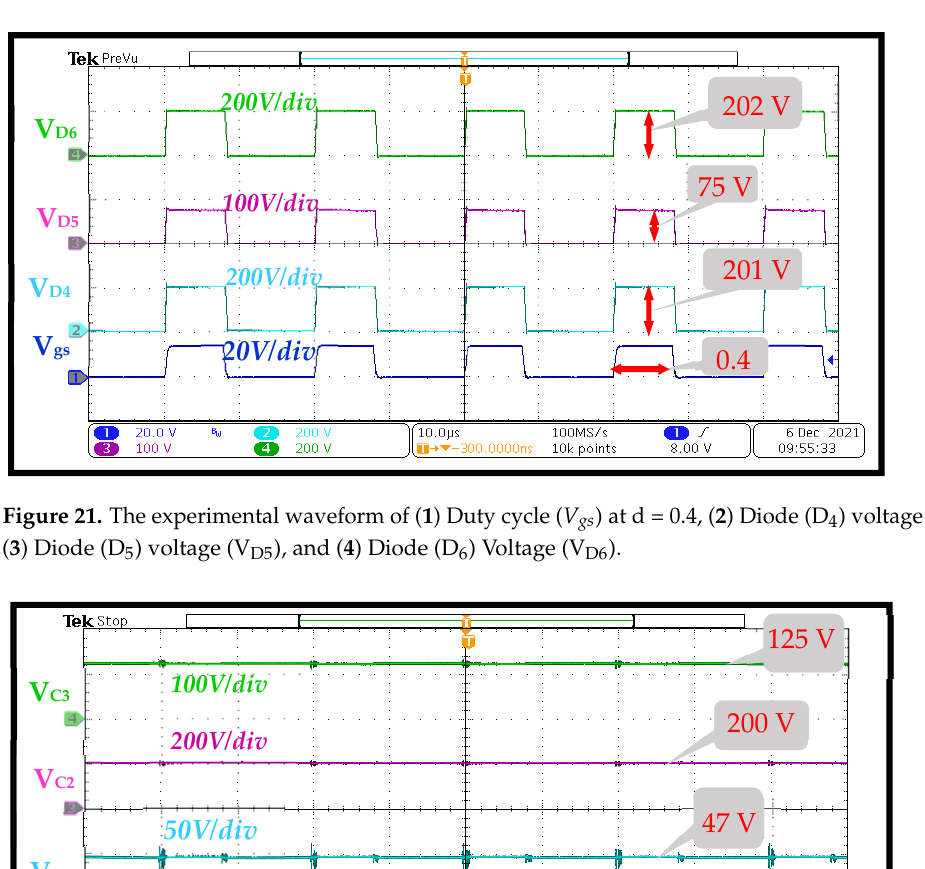
Figure 20. The experimental waveform of ( 1 ) Duty cycle (V gs ) at d = 0.4, ( 2 ) Diode (D 1 ) voltage (V D1 ), ( 3 ) Diode (D 2 ) voltage (V D2 ), and ( 4 ) Diode (D 3 ) Voltage (V D3 ).